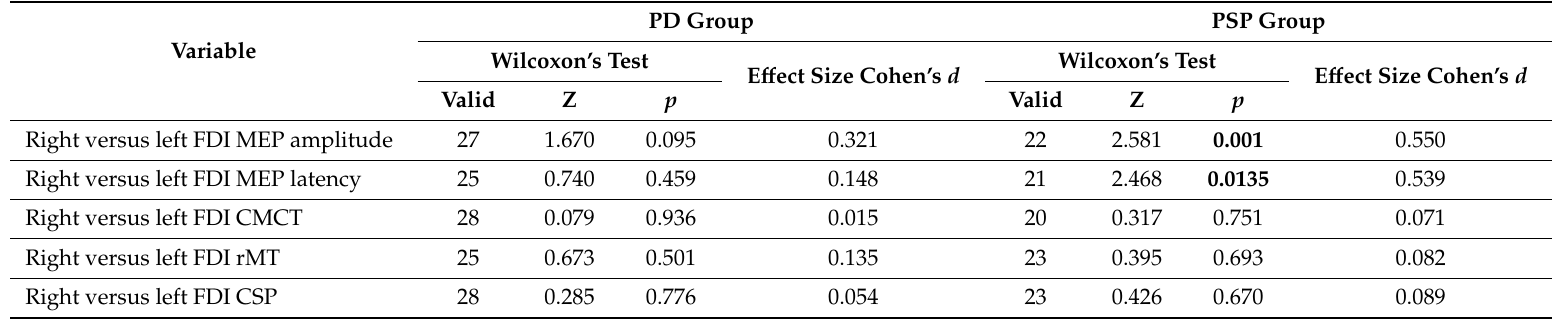
Table 3. Right-to-left di ff erence of TMS parameters within the PD and PSP